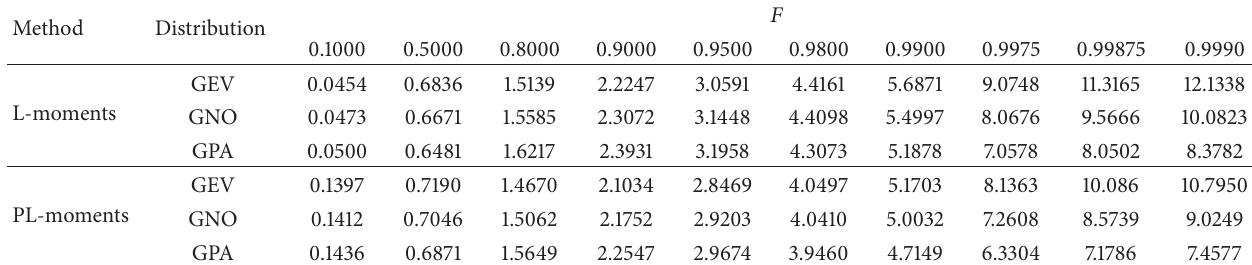
Table 7: Regional quantile estimates with nonexceedance probability 𝐹 .